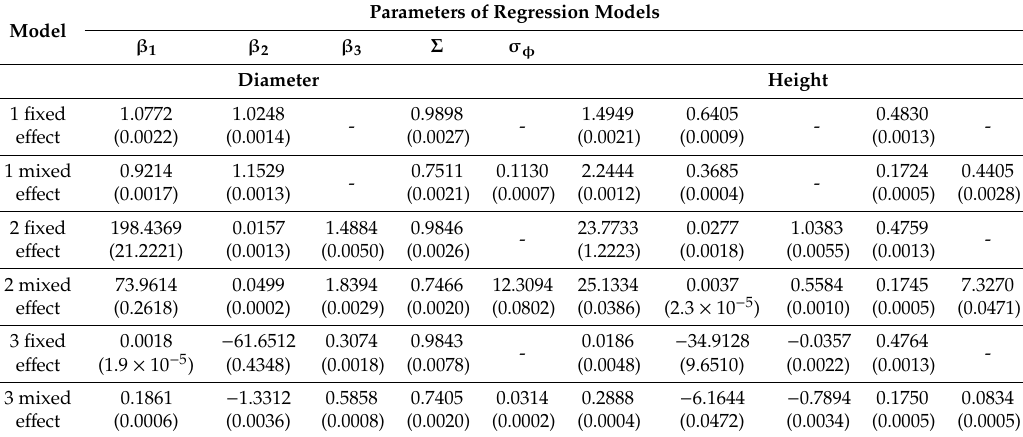
Table 7. Estimates of parameters and their standard errors (in parenthesis) for all fitted regression models.